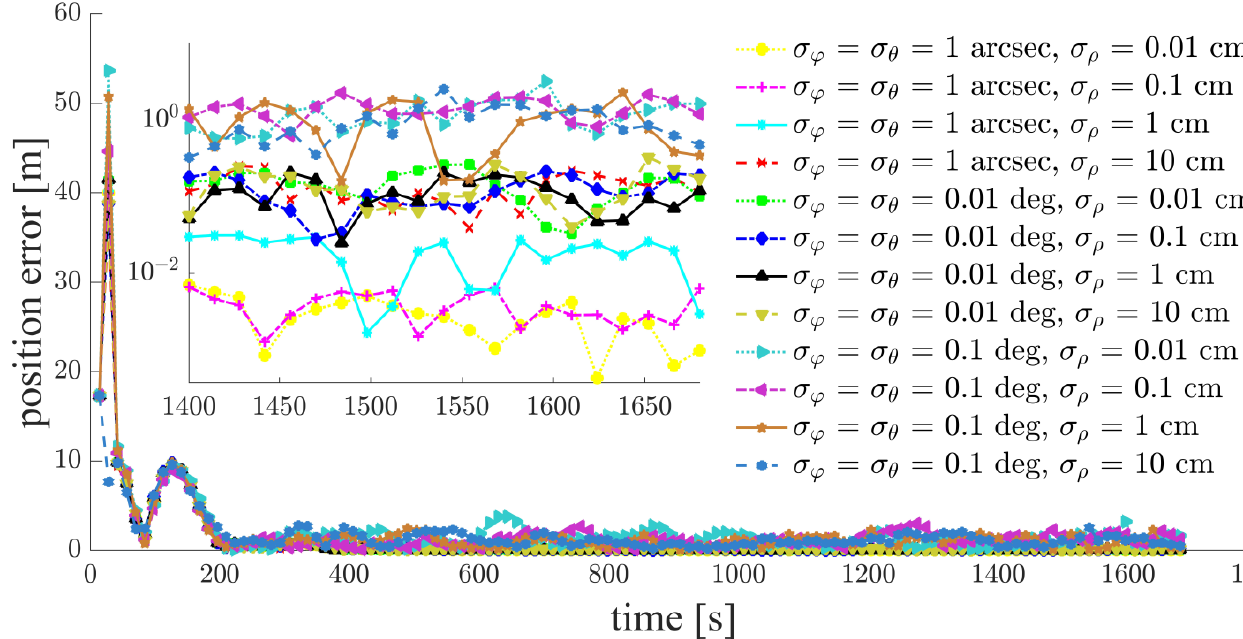
Figure 11. Relative navigation errors of 𝑆 1 (simulated scenario: Case d, space-circle formation radius of 1 km).